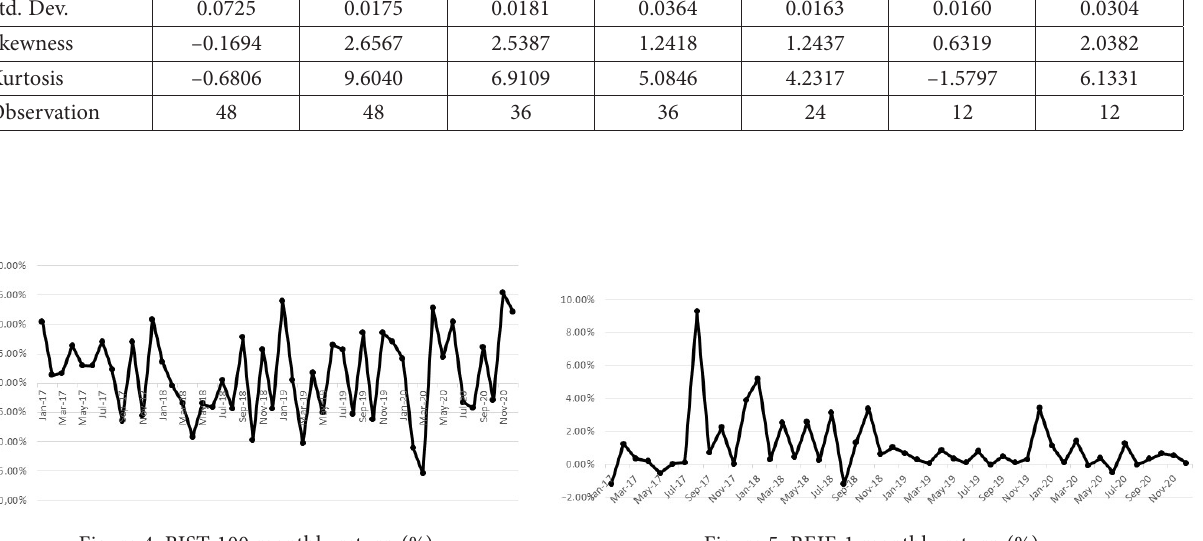
Figure 4. BIST-100 monthly return (%) Figure 5. REIF-1 monthly return